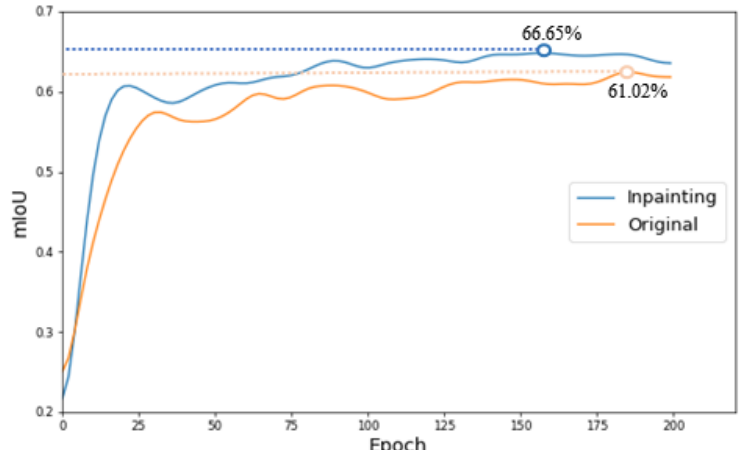
Figure A5. The accuracy graph of lesion segmentation of the PSPnet [47] model. The blue line represents the accuracy of using the inpainting images as the training set. The yellow line represents the accuracy of using the original images as the training